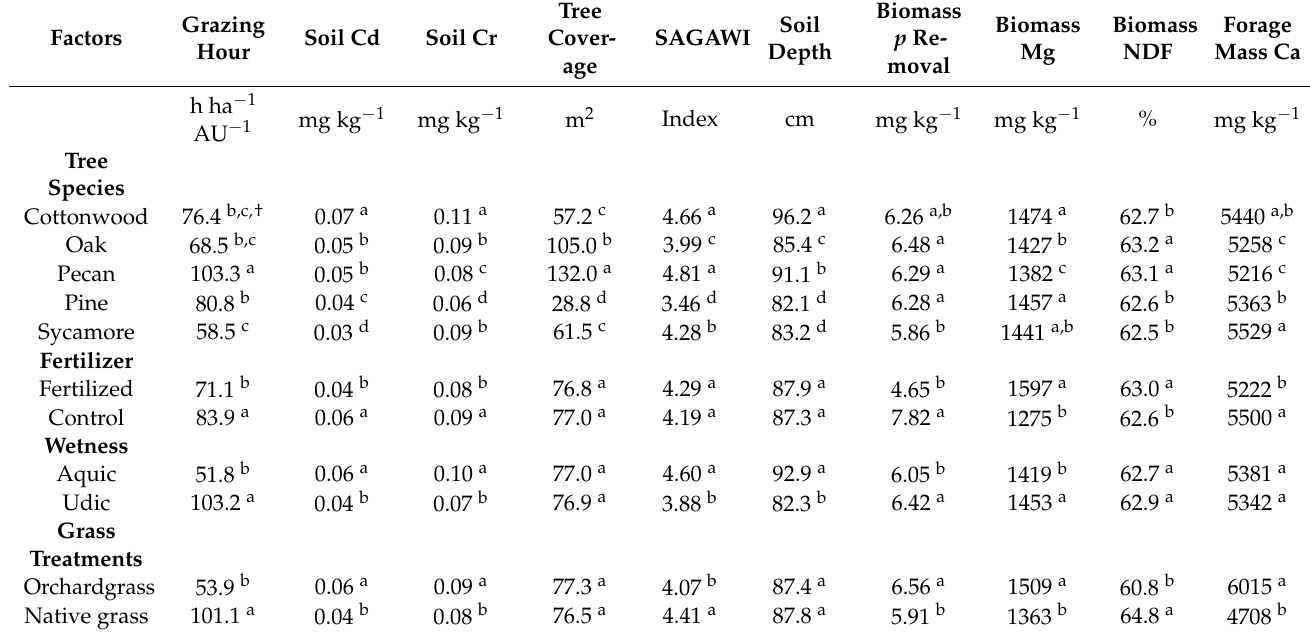
Figure 4. Regression tree developed for animal grazing hour based on the selected 40 (10 per cluster) important variables for system-level analysis. See Table 1 for the variable description. Table 3. Least square means of each selected variable as influenced by the experimental factor levels (tree species, ferilizer, wetness, and grass